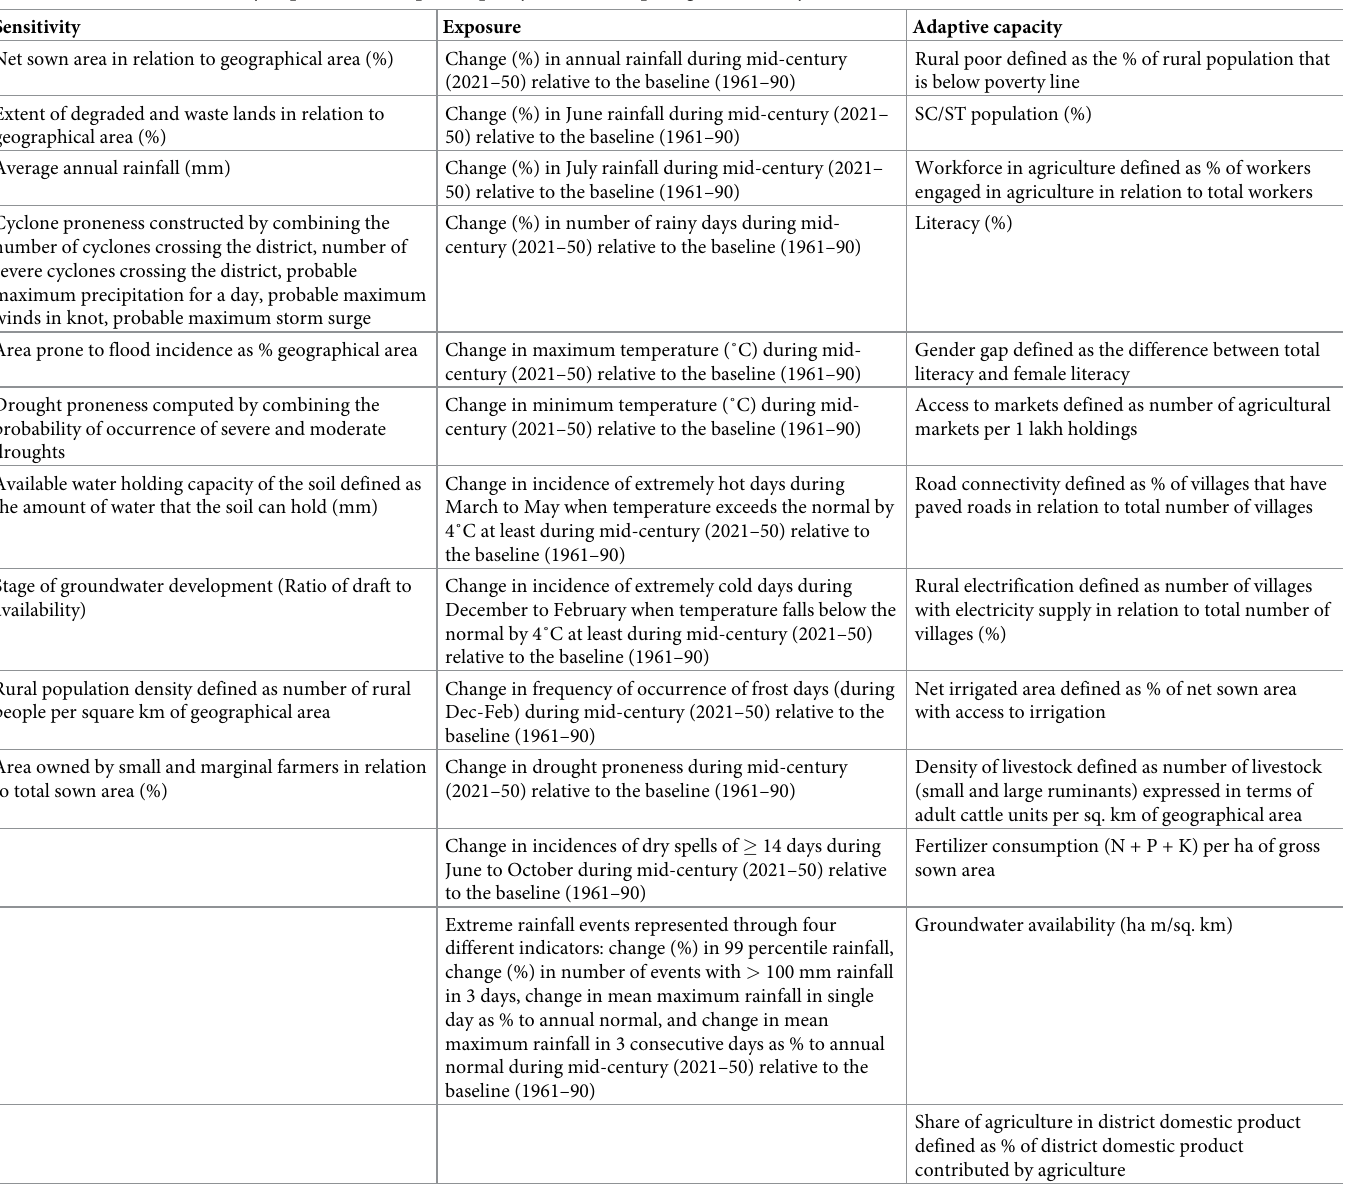
Table 1. Indicators of sensitivity, exposure and adaptive capacity used for computing vulnerability index.